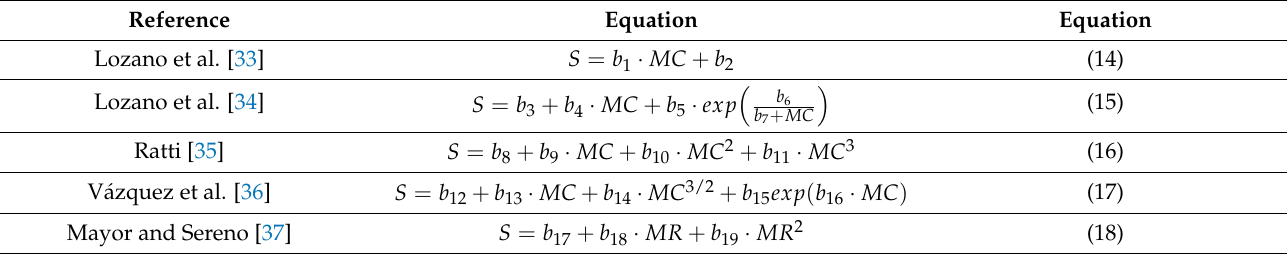
Table 1. Summary of empirical shrinkage models